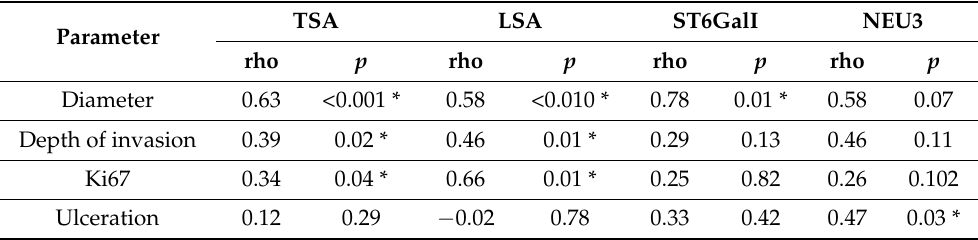
Figure 3. The serum levels of TSA, LSA, ST6GalI, and NEU3 in the studied groups (A = cSCC group, B = AK group, C = control group). Table 3. Correlations between the serum levels of TSA, LSA, ST6GalI, and NEU3 and histological features of